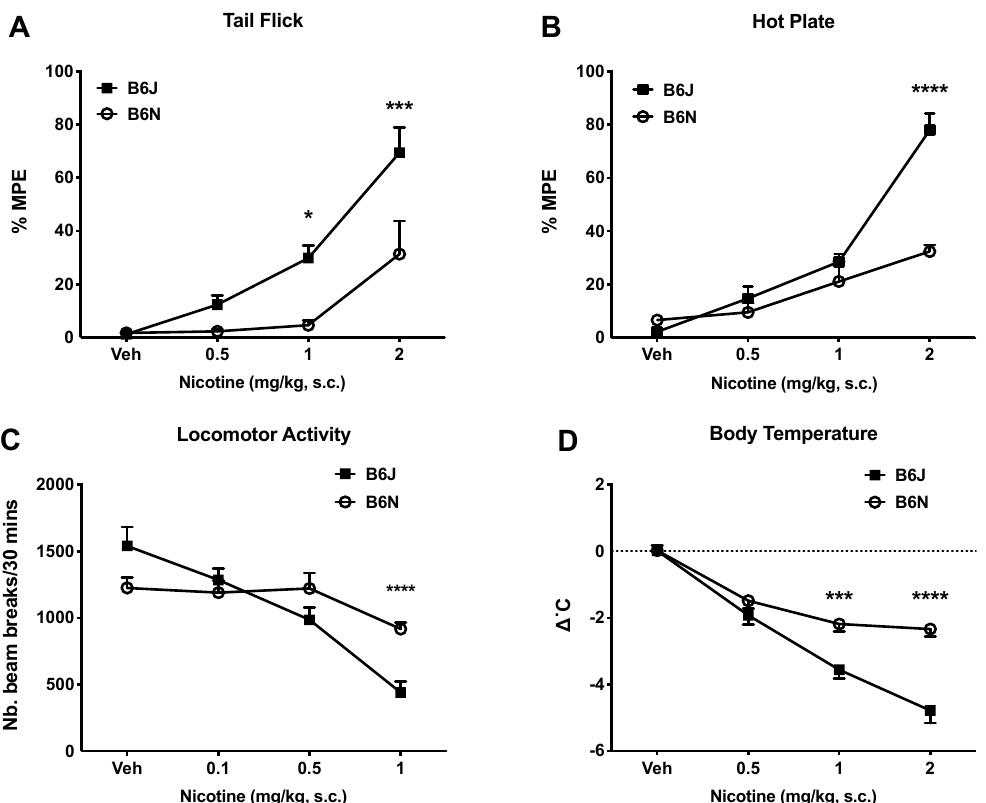
Nicotine (mg/kg, s.c.) Figure 1. Effects of acute nicotine on thermal antinociception, locomotor activity, and body temperature in the B6J and B6N substrains. Thermal antinociception is expressed as the percentage of the maximal possible effect in ( a ) tail flick and ( b ) hot plate test. ( c ) Locomotion response to acute nicotine in male B6J and B6N mice. ( d ) Body temperature in response to acute nicotine in male B6J and B6N mice. Nicotine (0.1, 0.5, 1, and 2 mg/kg) or the vehicle (0.9% saline) was administered subcutaneously. Each data point for thermal antinociception is represented by the mean %MPE + SEM. Significant difference is based on Holm-Sidak post-hoc test following the two-way ANOVA between both substrains (* p < 0.05, *** p < 0.001, **** p < 0.0001), n = 8/group. Table 1. A summary of nicotine’s potency in the tail-flick, hot plate, body temperature and locomotor activity tests after acute administration in male B6J and B6N mice. Potency is expressed as the ED50 ± confidence limits (mg / kg). Each group contained 8 mice. * CL of ED50 values do not